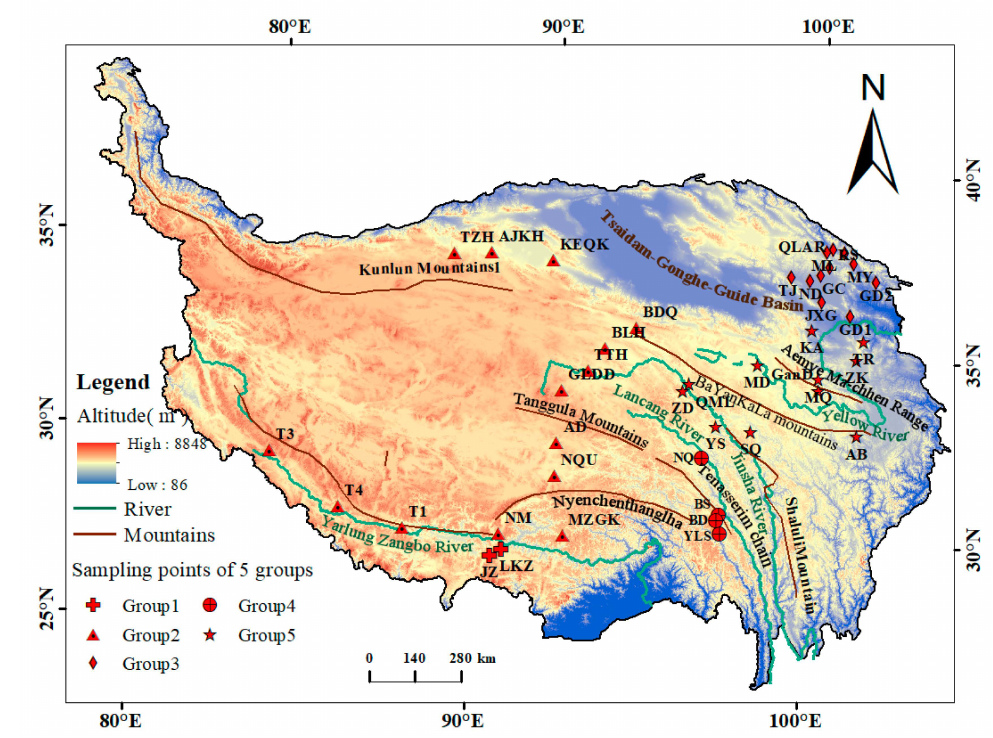
Figure 1. Map of sample locations for plateau